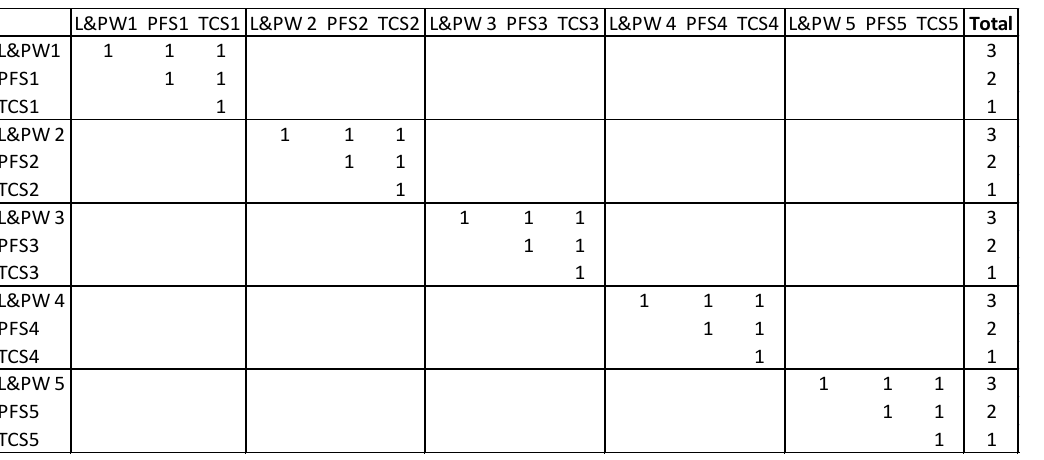
Figure 8. “N2 matrix for IZL”. Source: authors